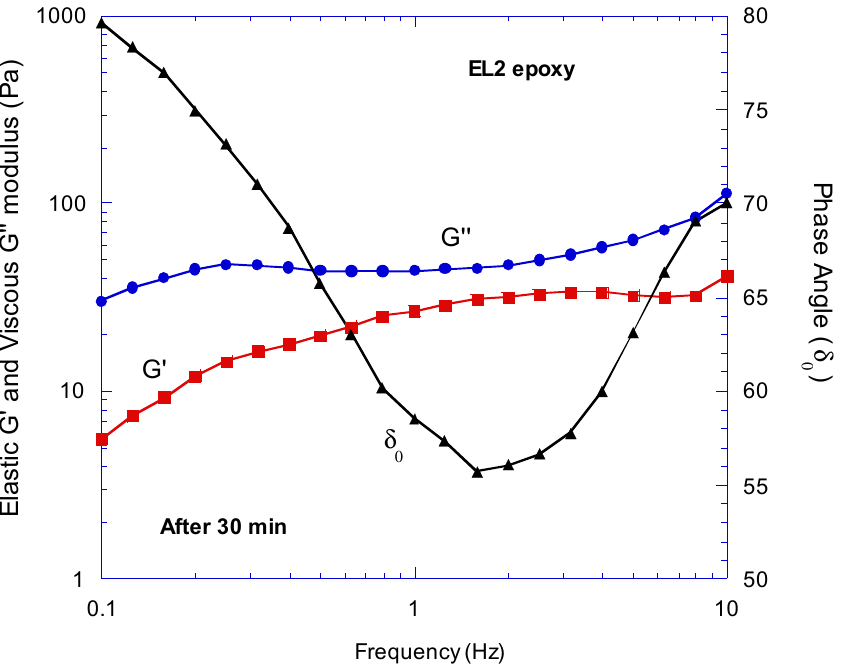
Figure 4. Frequency sweep result of EL2 epoxy 30 min after the mixing of the hardener.